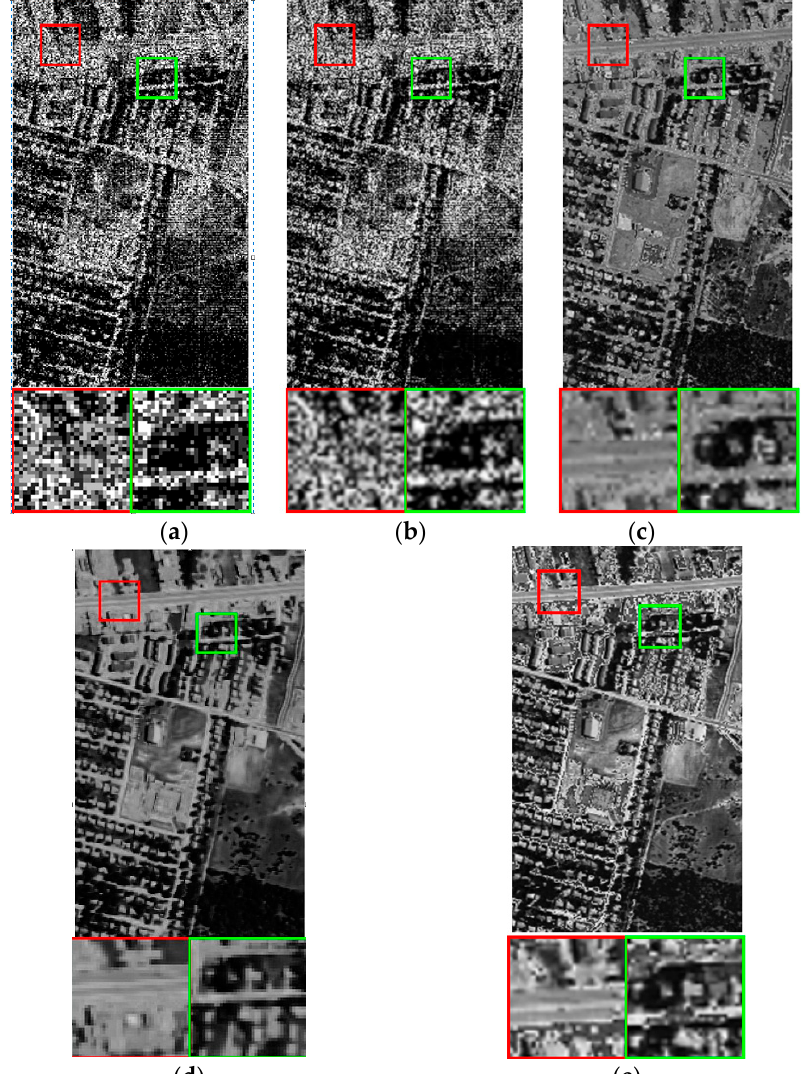
Figure 11. Visual results on band 188 of urban dataset: ( a ) Captured actual band, ( b ) Restoration results of VBM3D based method, ( c ) Restoration results of Godec based method, ( d ) Restoration results of SLrank based method, ( e ) Restoration results of the proposed method.